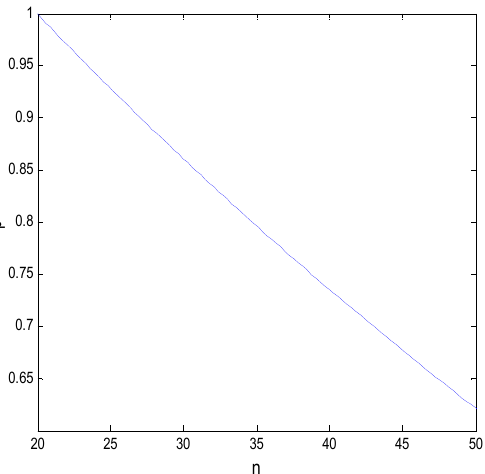
Figure 17. The effect of faculty inventors’ working years on their willingness to “comply with the rules”.